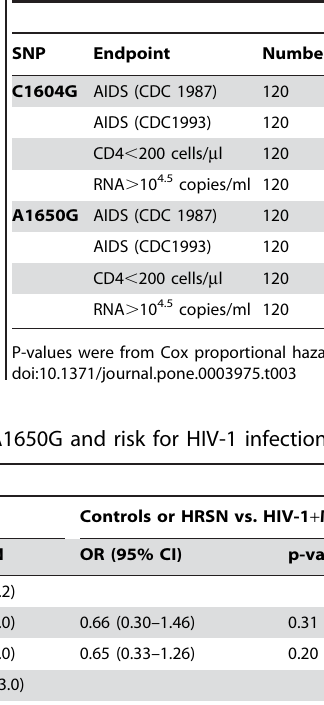
Table 3. Effects of CypA SNPs C1604G and A1650G on disease progression in DU of the Amsterdam